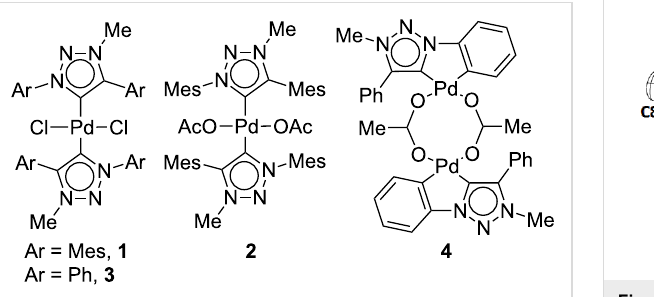
Figure 2: ORTEP representation of the structure of complex 1 in the crystal (35% probability ellipsoids). Hydrogens are omitted for